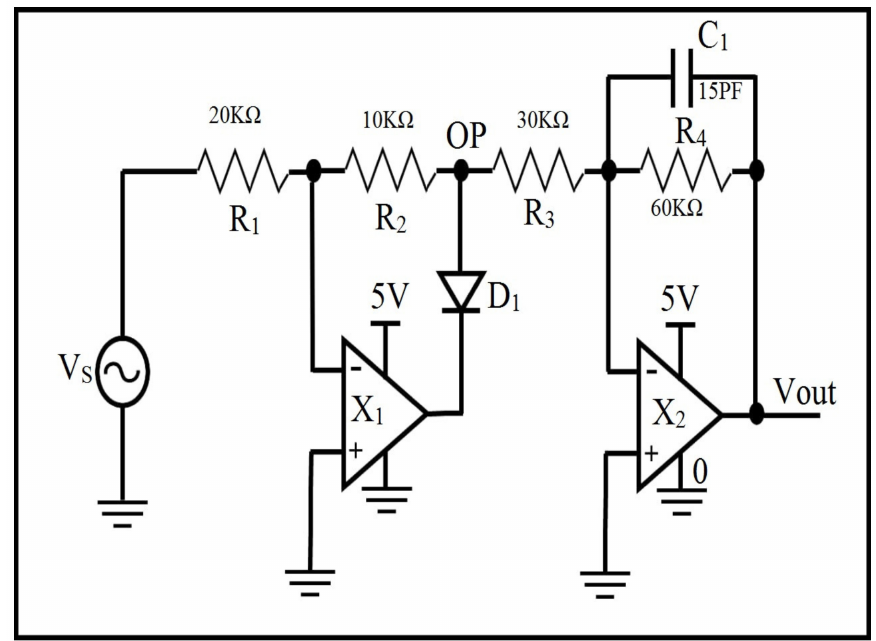
Figure 16. This circuit uses a single-supply operational amplifier to generate a full-wave rectifier.